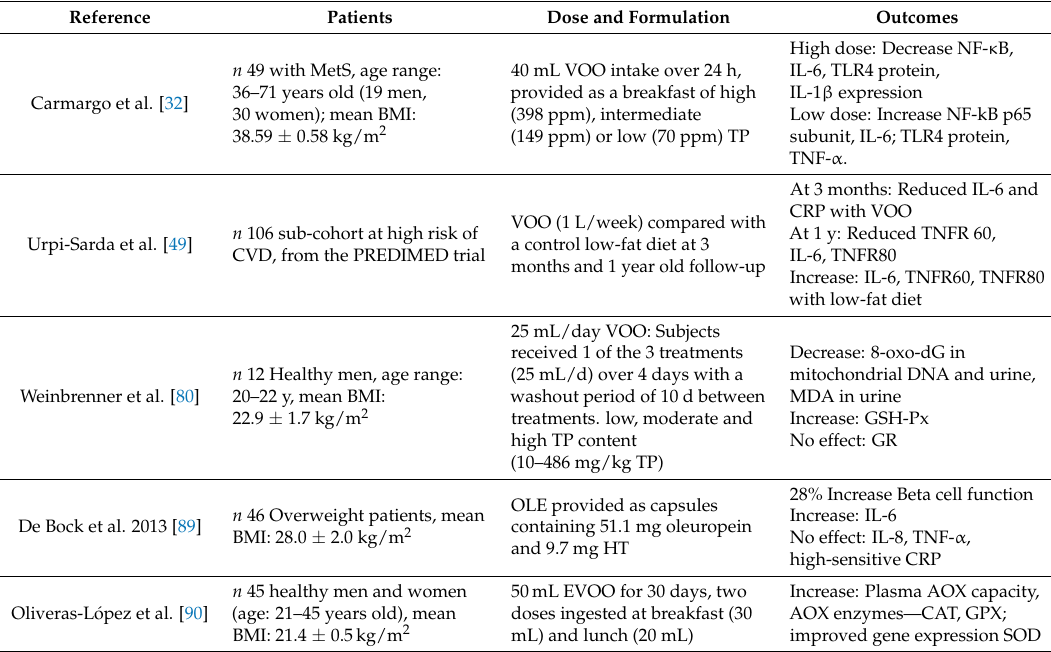
Table 1. Potential antidiabetic and anticancer dual effects of olive oil in human